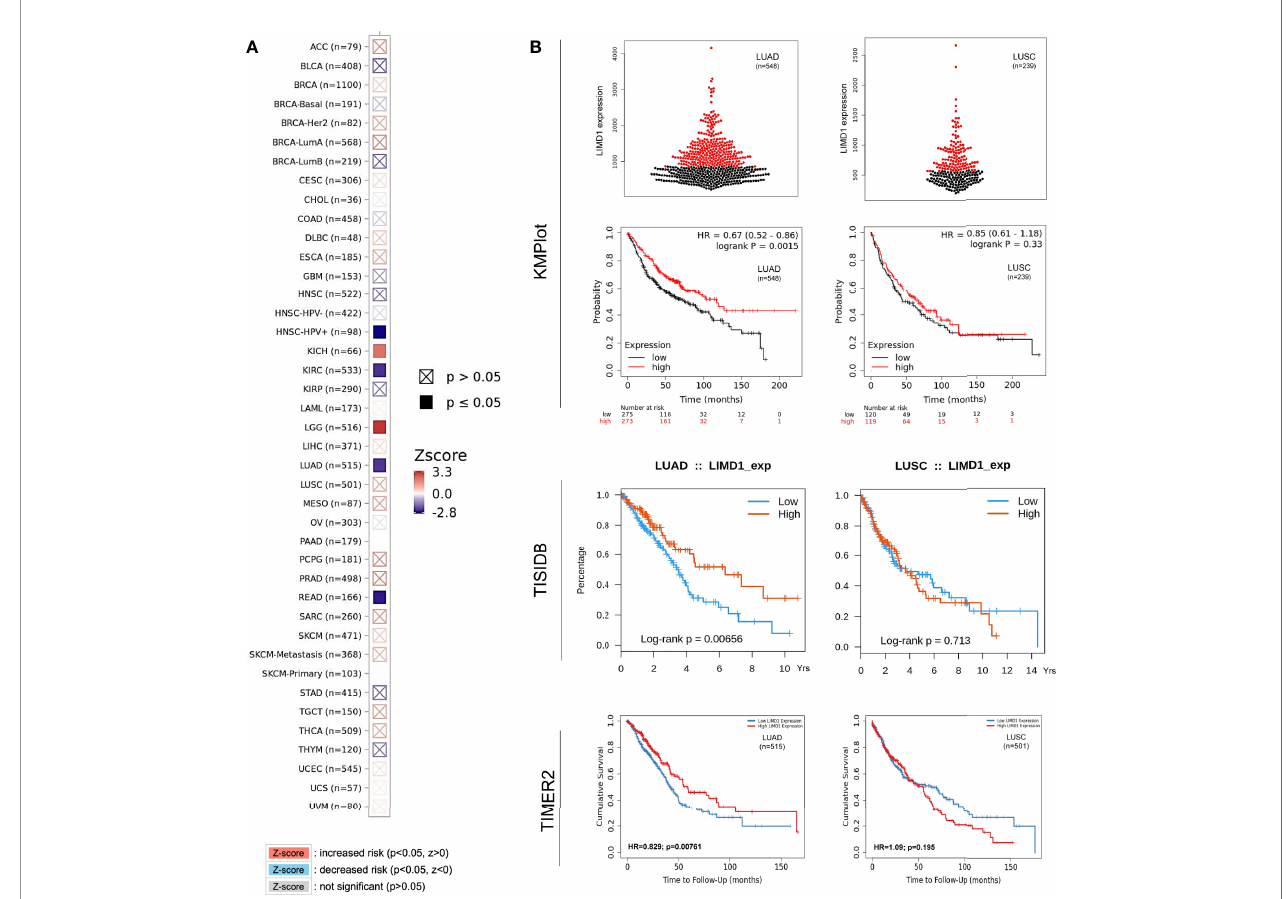
FIGURE 7 | LIMD1 correlates with the overall survival of certain cancers. (A) LIMD1 expression level correlates with the overall survival (OS) of certain cancer patients (200 months). (B) LIMD1 expression level signi fi cantly correlates with OS of LUAD patients, but not with LUSC patients. (A) are results from TIMER2, and (B) from different portals showing the consistency. For KMPlot, the settings were: only JetSet best probe set, excluding outlier arrays, and